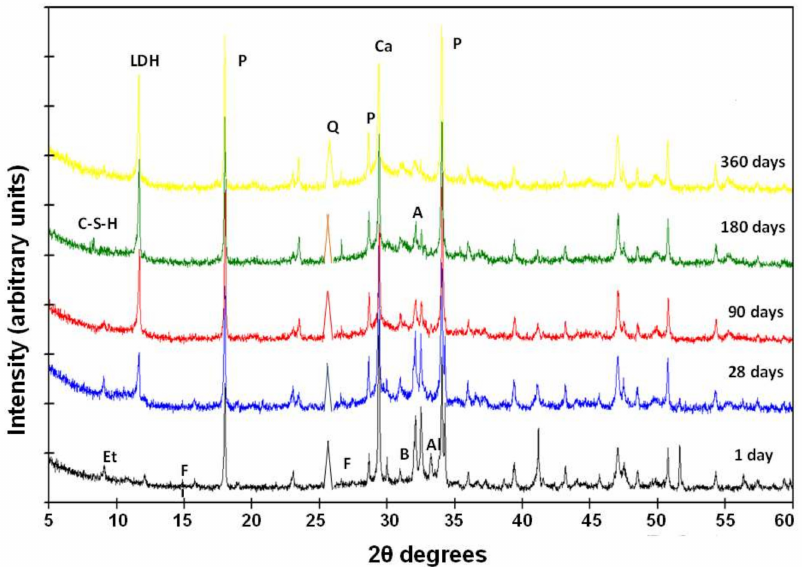
Figure 9. XRD patterns of the CPO with 10% addition of waste cured at 1, 28, 90, 180, and 360